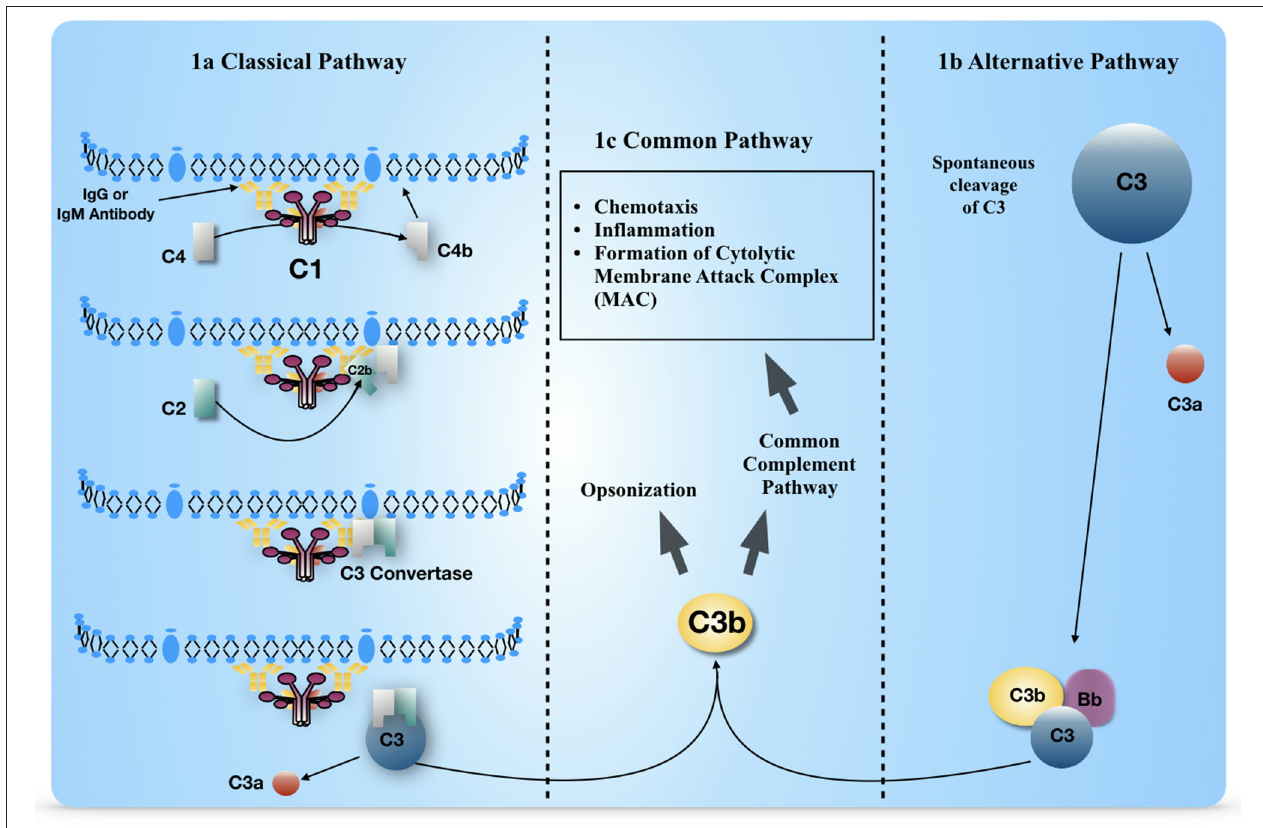
FIGURE 1 | Elements of the classical and alternative complement pathways, separated by the unique and common aspects. (a) Early steps of the classical pathway, to show activation and generation of C3 convertase enzymatic activity. C4b (soluble) is converted to C4b (membrane bound) via a thiol ester transesterification reaction (not shown in figure). (b) Early steps of the alternative pathway to show activation and generation of C3 convertase enzymatic activity. (c) Common aspects of complement pathway activation that result in macrophage and neutrophil recruitment and formation of the membrane attack complex, a cytolytic pore on the pathogen